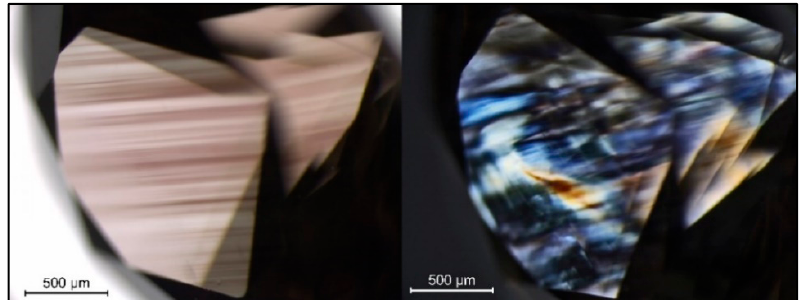
Figure 2. A pinkish brown type IaA>>B diamond (sample TH 2.440) in immersion (left) showing the characteristic plastic deformation-related brown “graining” along (111) combined with some pink “graining”, and the corresponding extinction and interference patterns as shown under crossed polarizing filters.